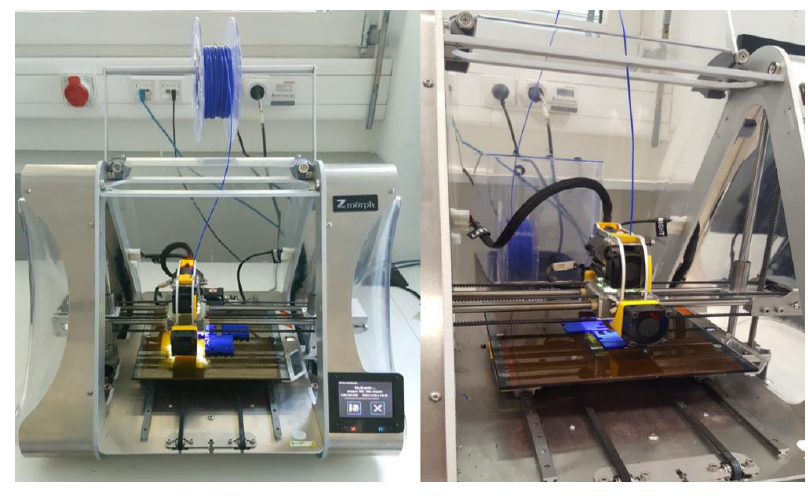
Figure 3. Zmorph 2.0 SX. Table 1. Printing parameters maintained constant during trials.